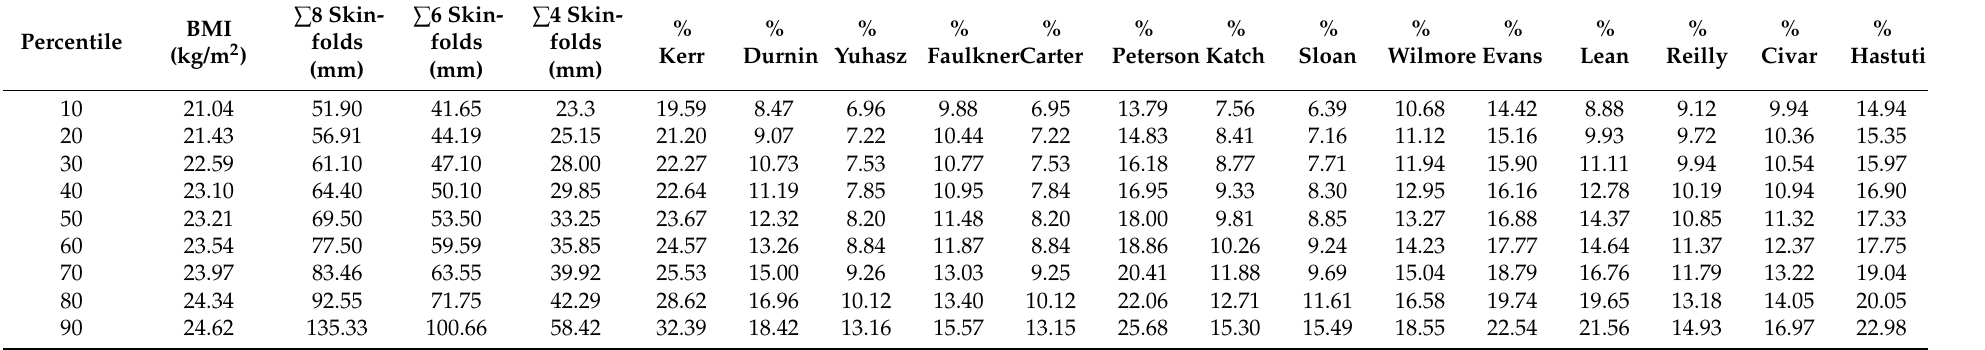
Table 8. Percentile relationships between BMI, skinfold sum, and adiposity formulas in men.